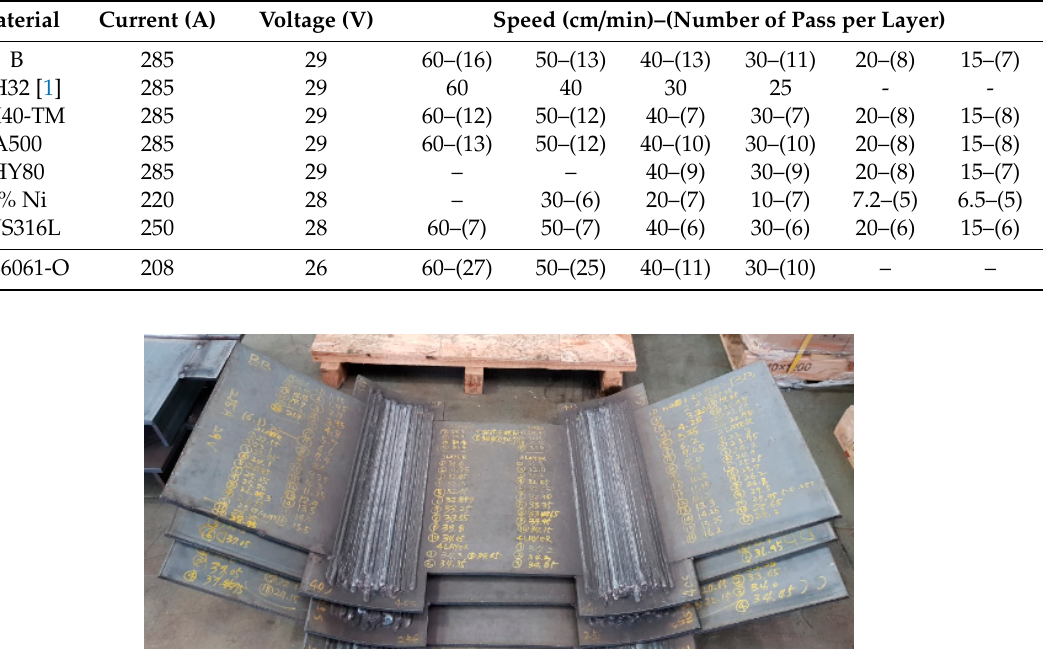
Figure 3. Welded specimens used to measure angular distortion. Table 3. Heat input conditions for BOP experiments.